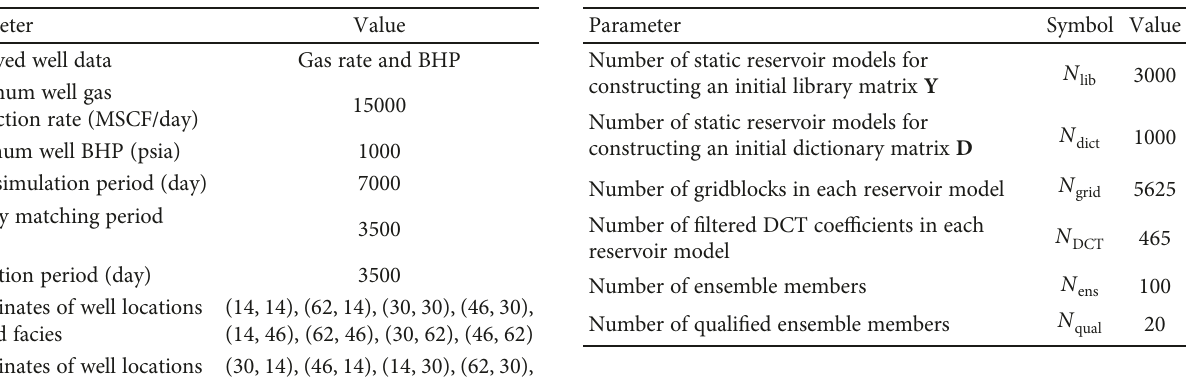
Figure 6: Training images and reference models adopted for history matching of (a) Case 1 and (b) Case 2. Table 3: Experimental data for well parameters used in Case 1 and Case 2.